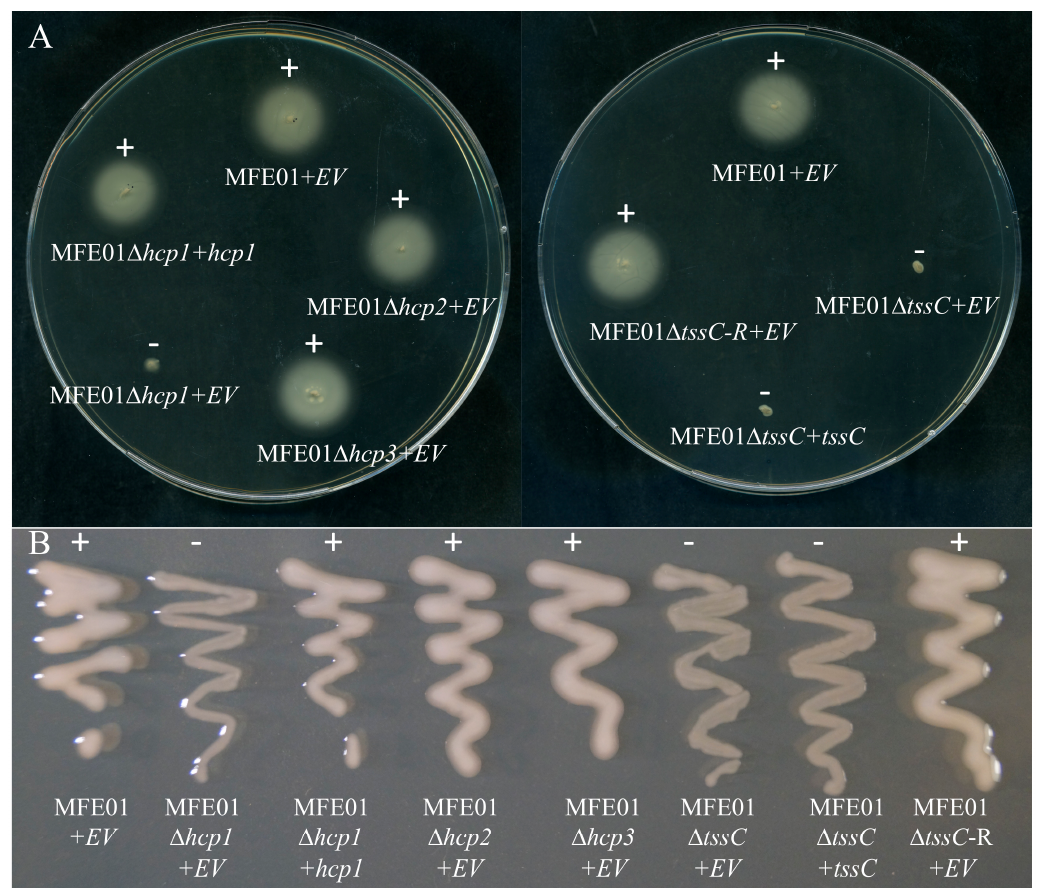
Figure 1. Swimming motility and mucoidy of P. fluorescens MFE01 and mutants. ( A ) “Swimming motility”. Swimmingassayswereperformedon0.3%LB-agar, supplementedwith50 µ g /